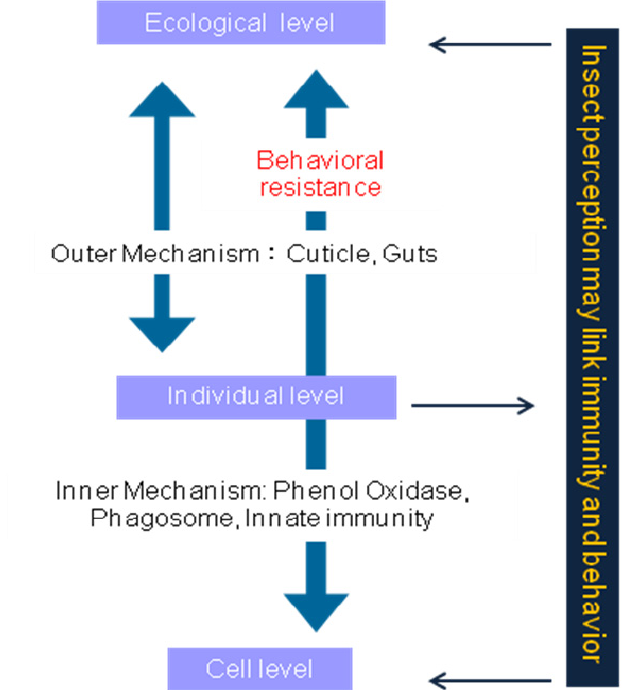
Figure 3. Interaction between Resistant Level Insects employing strategies to fight against microbial infection at cell, individual and ecological levels. Behavioral resistance is often the first defense in the infection